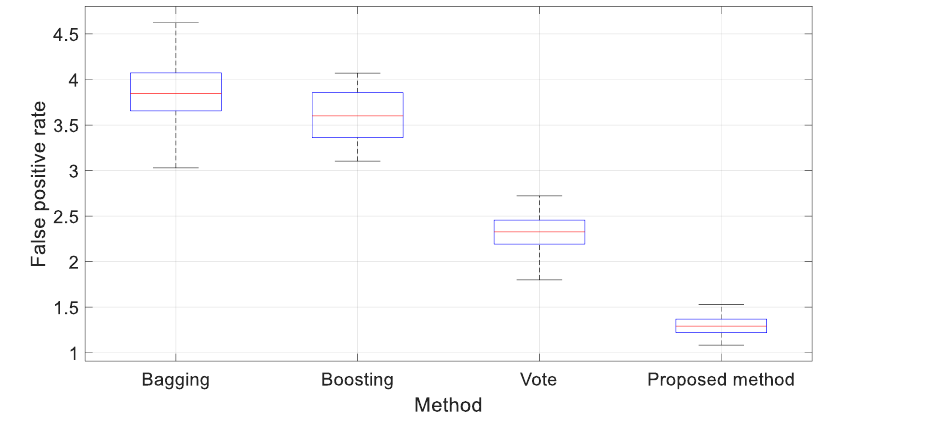
Figure 9. Box diagram of false positive rate.